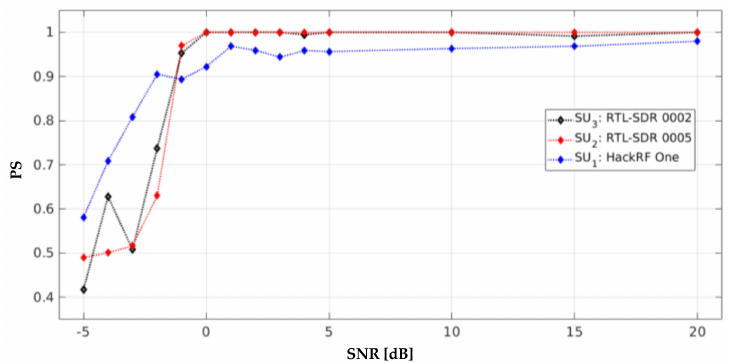
Figure 20. Probability of success of each SU in the controlled